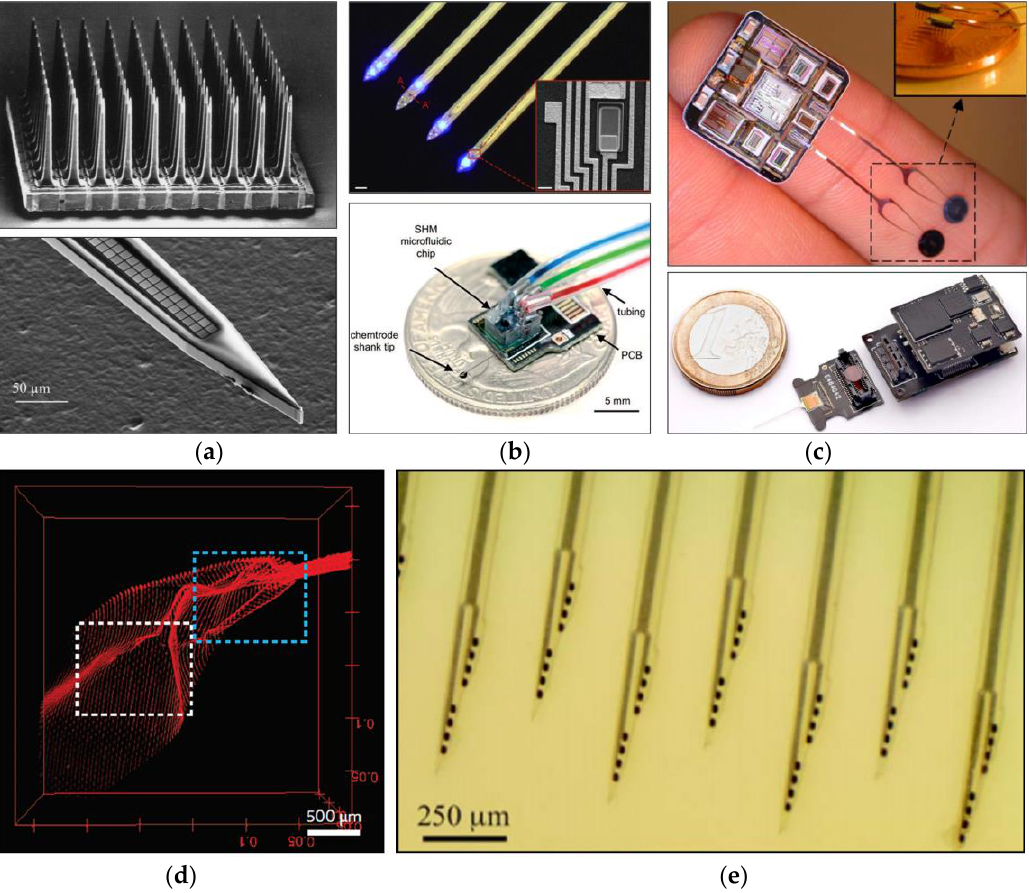
Figure 2. Optical photographs of the state-of-the-art neural probes: ( a ) high density (top: 3D array from Normann et al. [24]; bottom: 200-electrode shank from Scholvin et al. [17]); ( b ) functionalities (top: micro-LED for optogenetics from Wu et al. [13]; bottom: mixer-integrated microfluidic channel for drug delivery from Shin et al. [11]); ( c ) integrated circuits (top: a 64-channel integrated circuit (IC) with wireless transmission from Sodagra et al. [19]; bottom: a 52-channel IC from Lopez et al. [18]), and ( d-e ) biocompatibility (( d ): syringe-injectable flexible 3D probe from Liu et al. [62]; ( e ): dissolvable silk-coated probe from Wu et al. [35]). Standard neural probes consist of single or multiple shanks and microelectrode arrays integrated at the end of the shanks for neural recording; The syringe-injectable probe shown in ( d ) is a new type of neural probe which provides 3D access to the brain with minimal damage. All figures reprinted with permission.